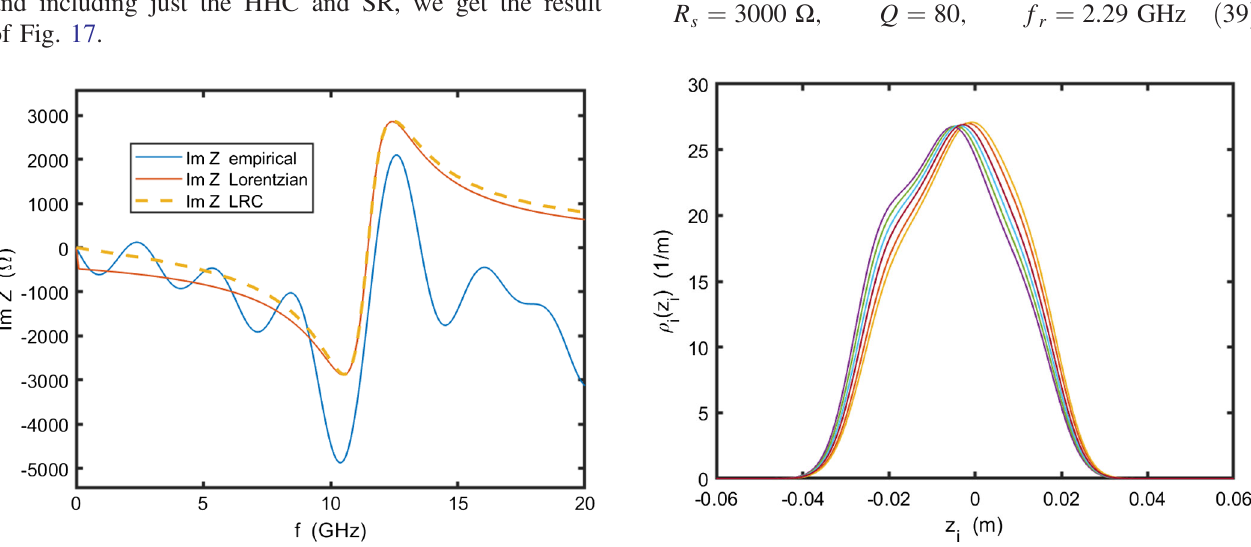
FIG. 18. Fill C2, HHC þ SR, I